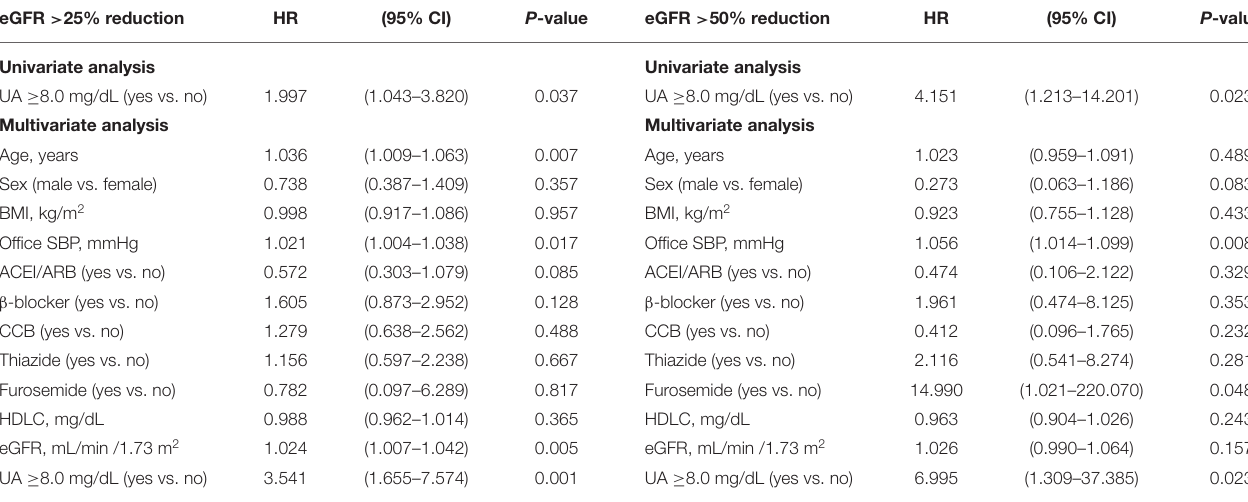
TABLE 6 | Uric acid 8.0 mg/dL and decline of estimated glomerular filtration rate